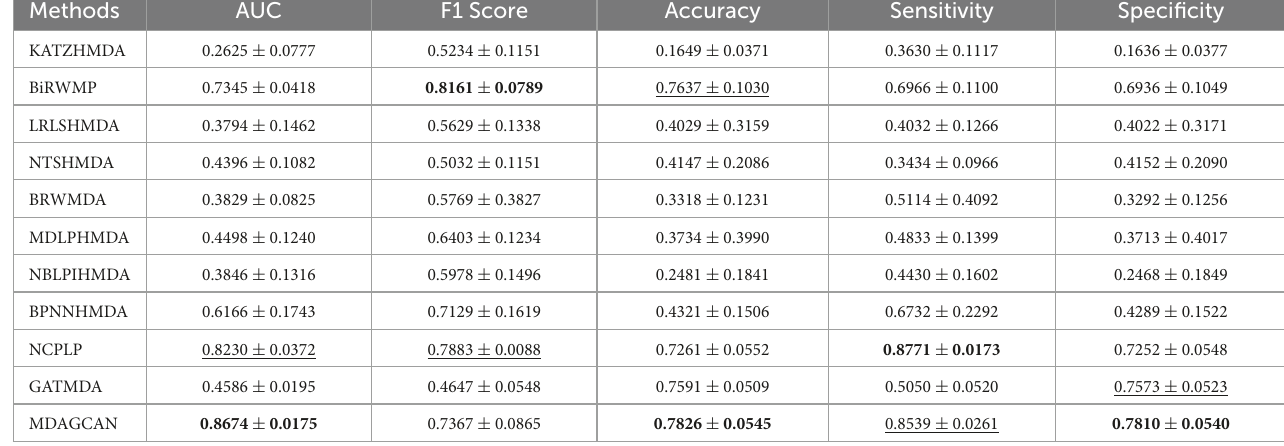
TABLE 2 Performance comparison between 10 baseline methods and MDAGCAN under horizontal test for diseases in 5-fold CV on HMDAD dataset.